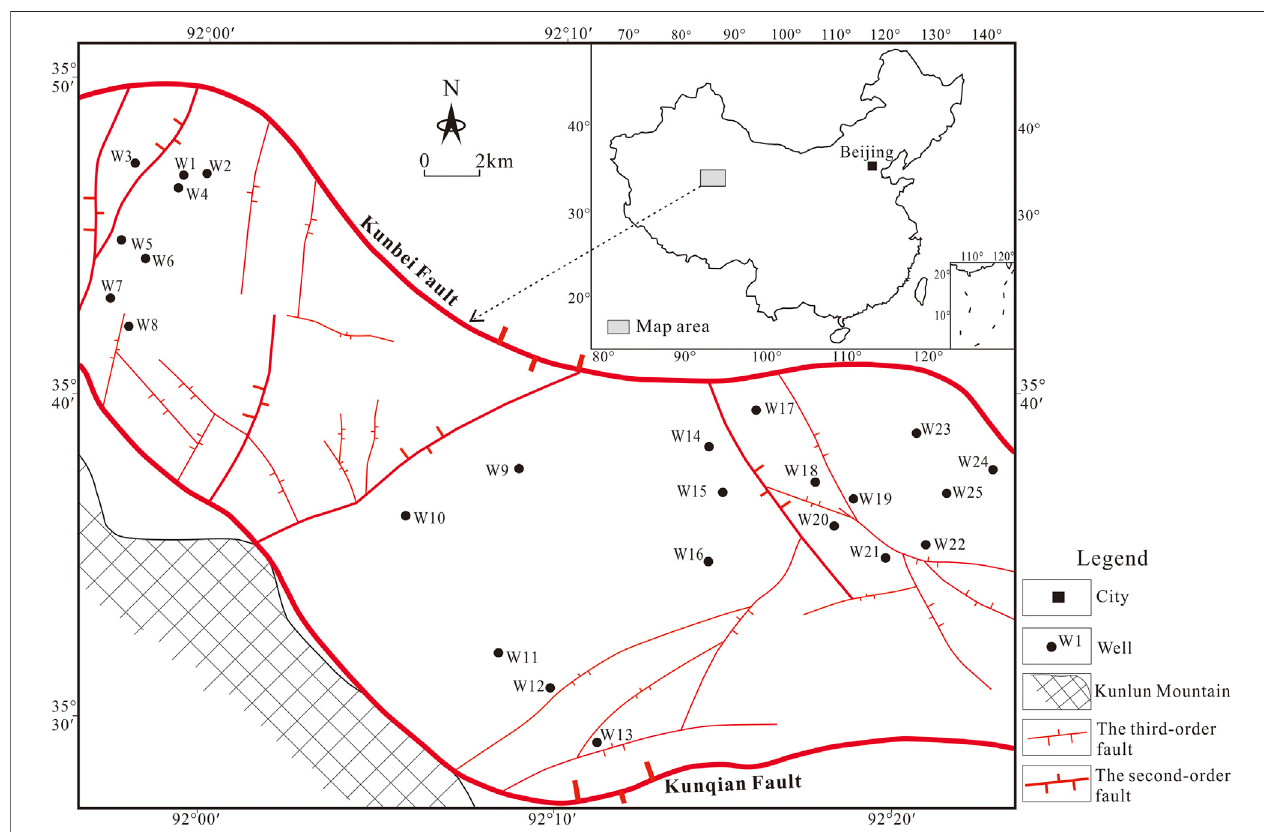
FIGURE 1 | Structure location of the study